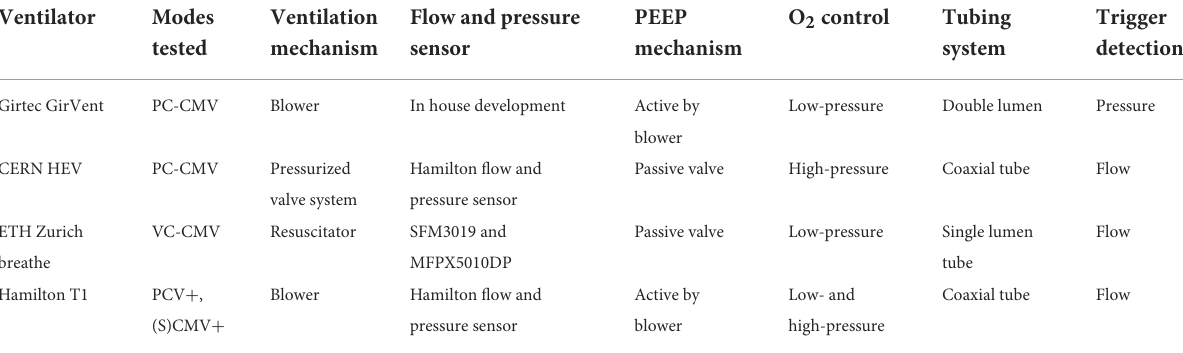
TABLE 1 Overview of the basic characteristics and auxiliary material of each ventilator tested. Ventilator